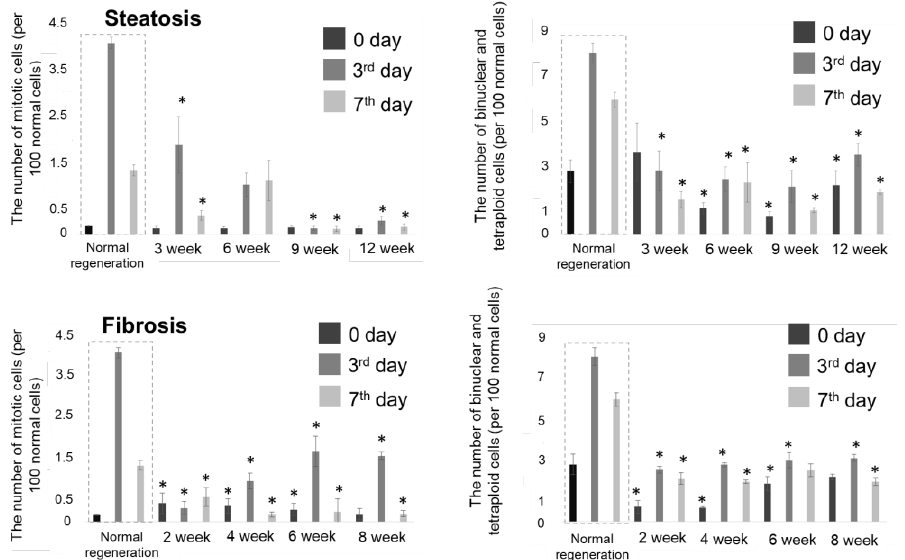
Figure 2. Morphometric analysis of liver tissue at different stages of normal regeneration and regeneration with steatosis and fibrosis. The charts show the number of tetraploid and binucleate cells during regeneration and the number of mitotic cells during regeneration. Values are presented as the number of dividing cells per 100 non-dividing cells. Mean ± SD. * — statistically significant difference compared to the corresponding time point for normal regeneration, p - value ≤ 0.05.